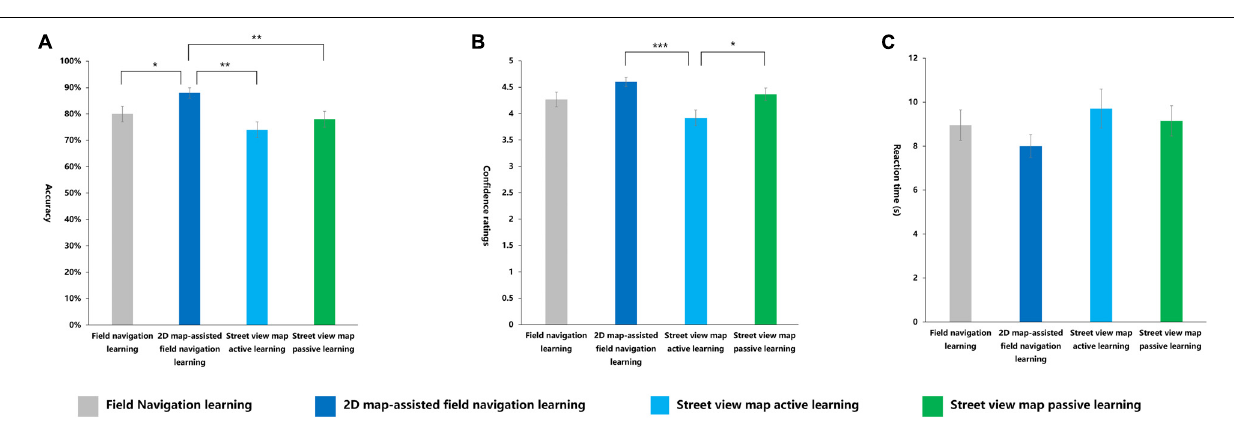
FIGURE 12 | Indexes in orientation judgment task under four learning methods. (A) Accuracy, (B) confidence ratings, (C) reaction time (s). *** p < 0.001.